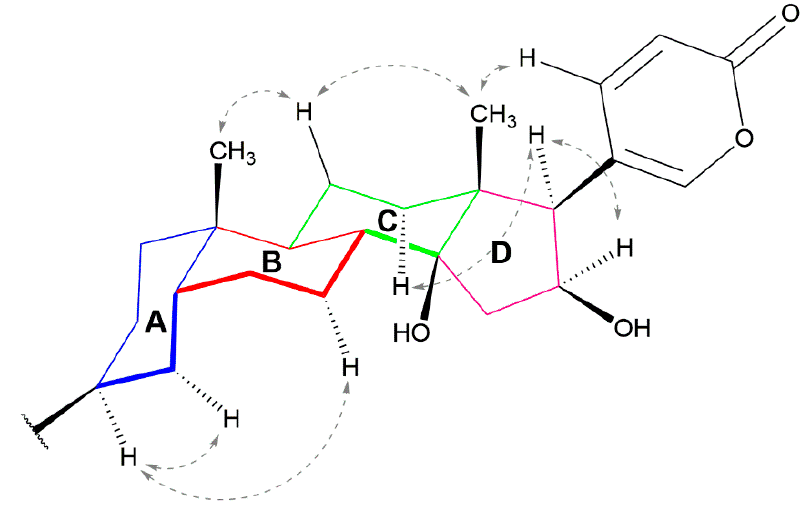
Figure 2. Key NOESY correlations for compound 1 .